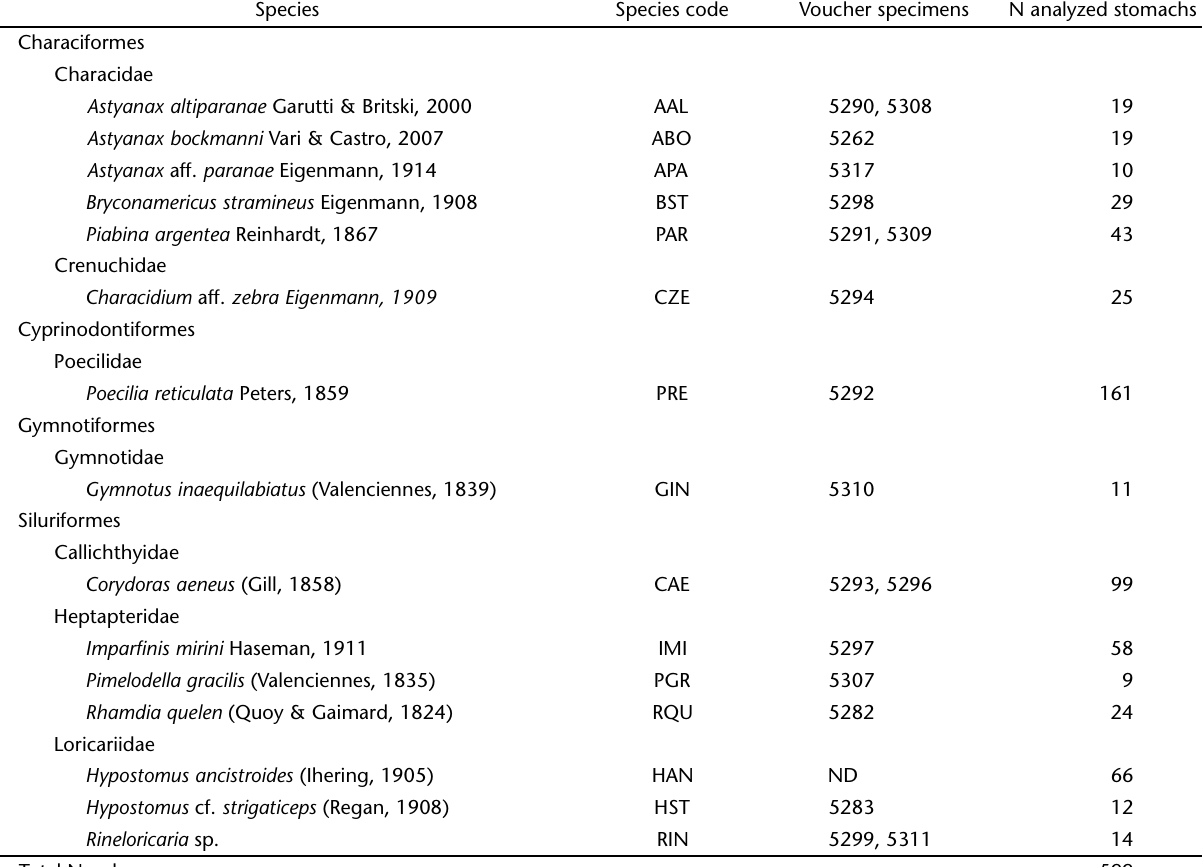
Table II. Taxonomic position and number of stomachs analyzed for the fish species from the sampled streams. The list of species recorded and their taxonomic positions are consistent with R EIS et al. (2003) and G RAÇA & P AVANELLI (2007).